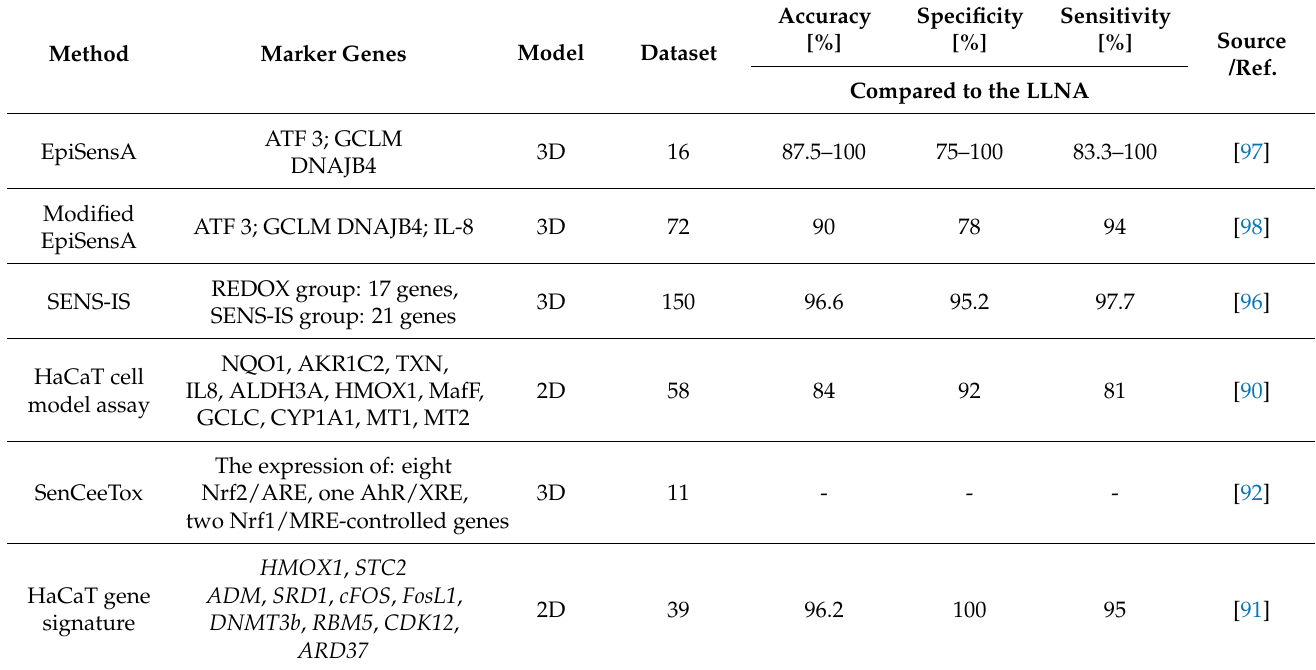
Table 4. KE2. Methods based on gene expression